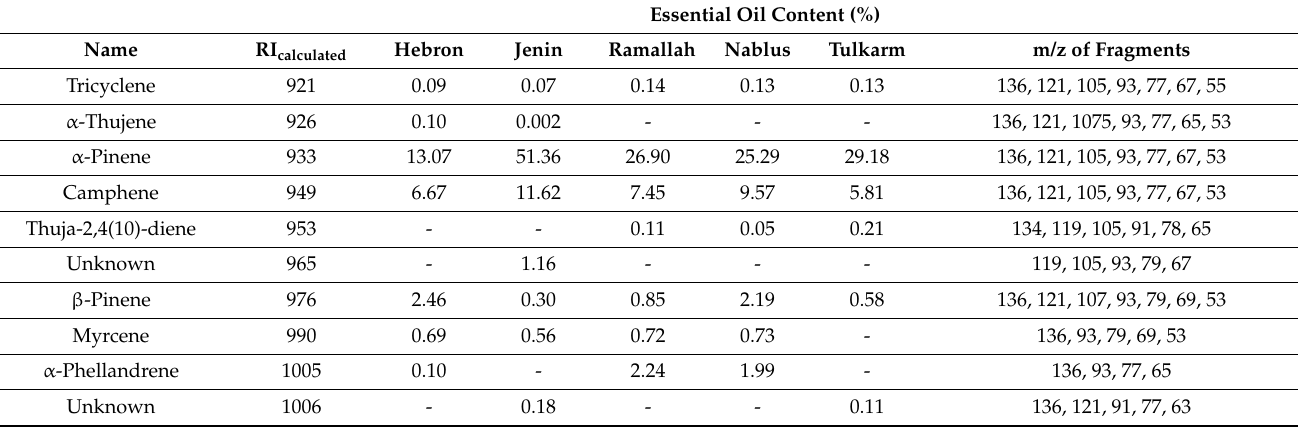
Table 1. Phytochemical compositions of Rosmarinus officinalis essential oils collected from five different Palestinian